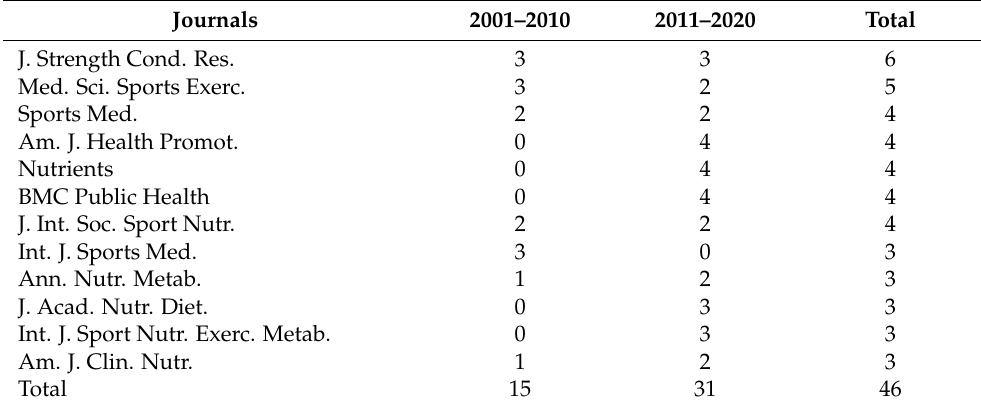
Table 1. Publications trends on coffee/caffeine and sport for core journals between 2001 and